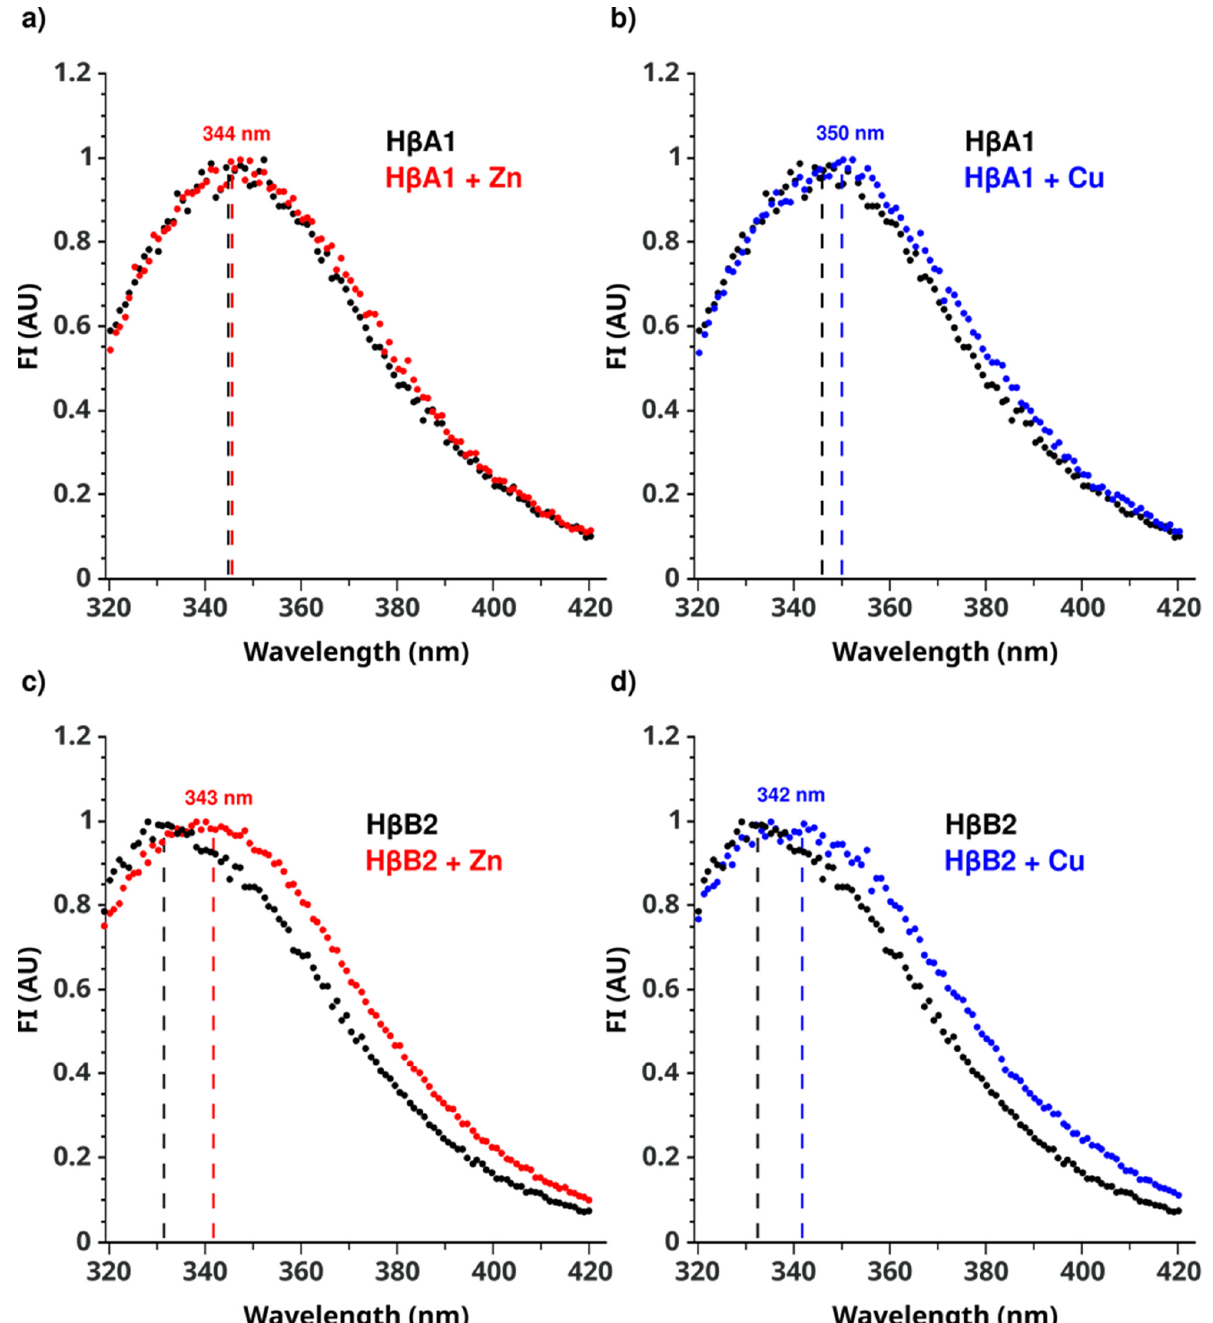
Figure 4. Normalized Intrinsic fluorescence. ( a ) H β A1 in the absence of metal ions (black) and in the presence of Zn(II) (red). ( b ) H β A1 in the absence of metal ions (black) and in the presence of Cu(II) (blue). ( c ) H β B2 in the absence of metal ions (black) and in the presence of Zn(II) (red). ( d ) H β B2 in the absence of metal ions (black) and in the presence of Cu(II) (blue). The emission spectrum was recorded in the range of 300 and 500 nm using an excitation wavelength of 295 nm at 37 °C. (Replica spectra are shown in Figure S7).